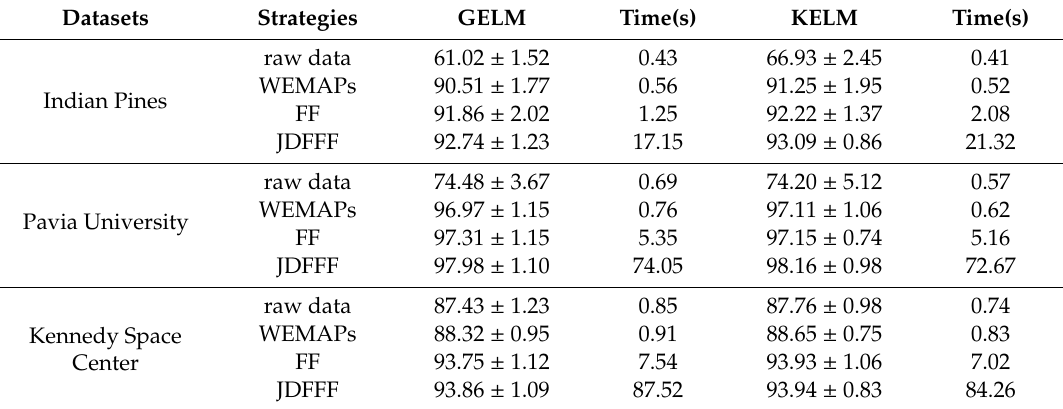
Table 3. The classification overall accuracies (in percentages) on these three datasets with 15 labeled samples per class for training.